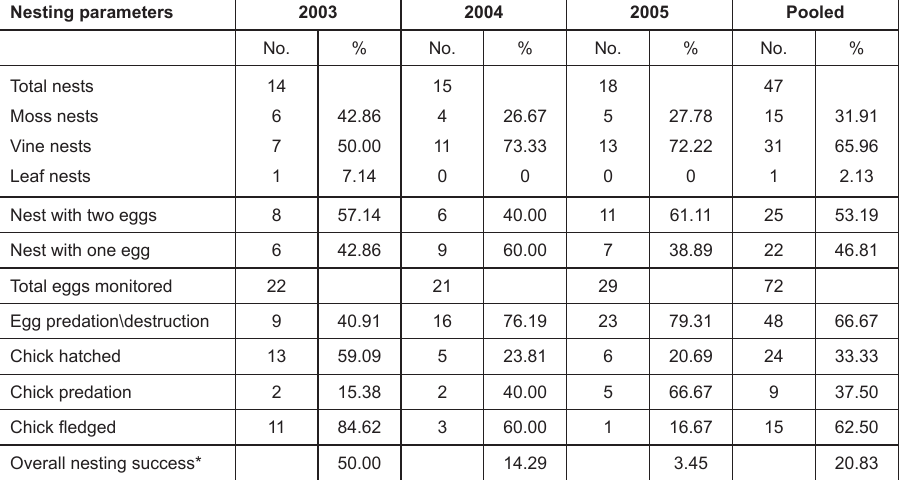
Table 1. Breeding performance of Grey- headed Bulbul in Silent Valley National Park during 2003–2005. *calculated as an index of chick fledged versus eggs